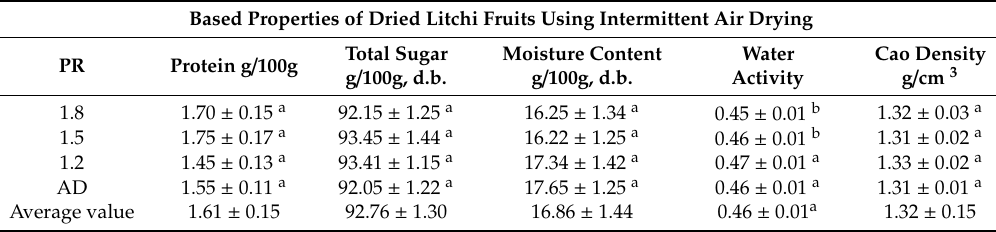
Table 3. Approximate nutrition of litchi pulps dried by drying schemes with di ff erent pulse